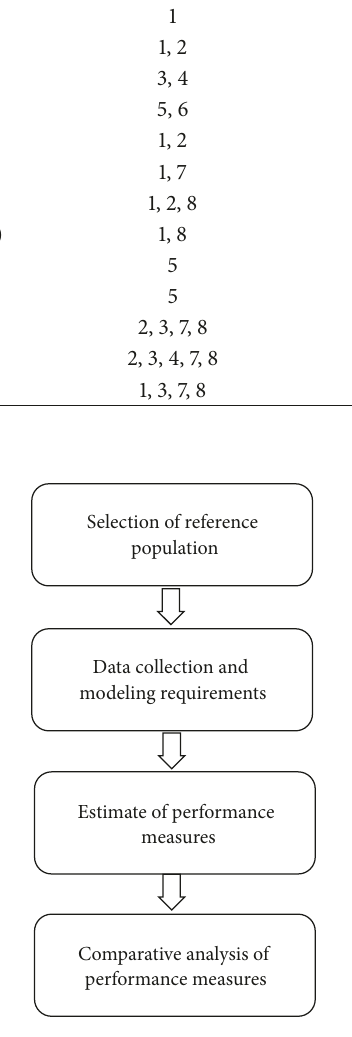
Figure 1: Flowchart for comparative analysis of safety performance measures for hotspot identification.